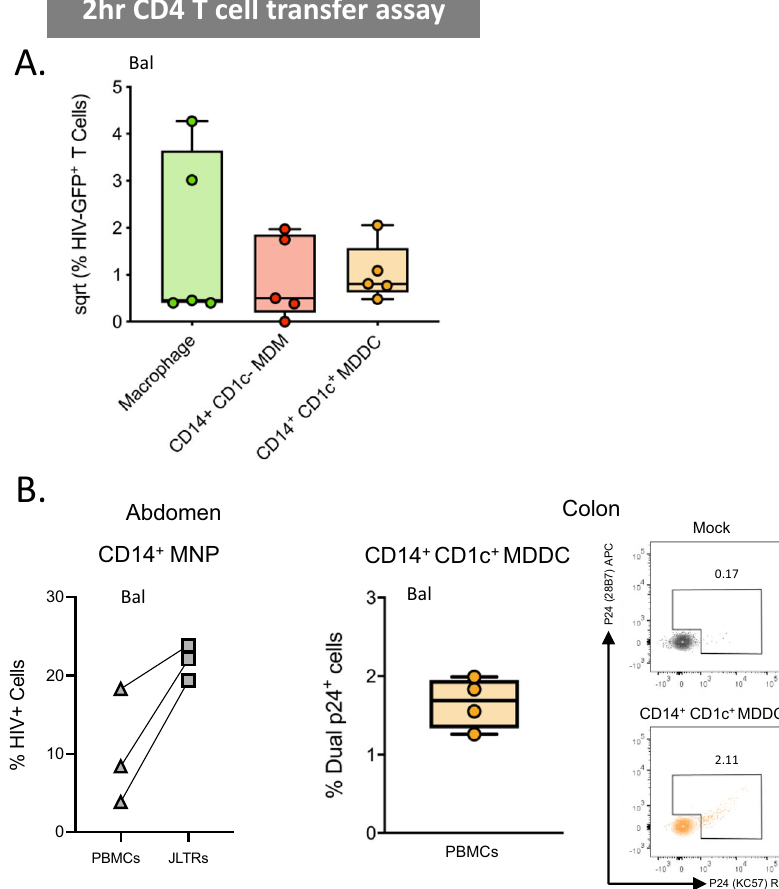
Fig. 6 1 st phase HIV transfer from CD14-expressing mononuclear phagocytes to CD4 + T cells. A Sorted CD14-expressing dermal cells were incubated with HIV Bal for 2 h and then thoroughly washed off. JLTR cells were added to MNPs at a ratio of 4:1 and cultured for a further 96 h in human fi broblast conditioned media. Transfer of HIV to T cells was assessed using fl ow cytometry to plot the square root percent of GFP + T cells, with each dot representing an individual donor ( n = 5). B Left: CD14-expressing MNPs were sorted and 2-h transfer ability to JLTR cells compared to primary activated CD4 T cells derived from PBMCs was assessed ( n = 3). Primary CD4 T cells were cultured at a ratio of 2T cells: 1 MNP. The number of infected T cells was assessed by fl ow cytometry using Live/dead NIR and intracellular P24 staining. Three individual MNP donors were plotted with squares representing transfer to primary CD4 T cells and triangles representing transfer to JLTR cells. Right: CD14 + CD1c + MDDC from four human colonic tissue donors were sorted and 2-h transfer assays to CD4 T cells from PBMCs were setup as above, plotted as box and whisker plots, box representing the upper and lower quartile, central line representing the median, the whiskers the minimum and maximum and each donor represented by an individual dot ( n = 4). Representative contour plots from one individual donor are shown. Macrophages (green), CD14 + CD1c − MDM (red) and CD14 + CD1c +